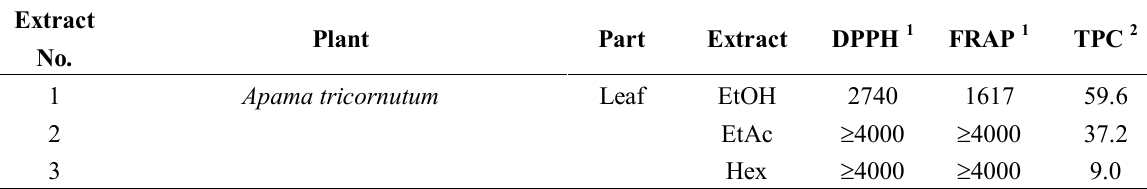
Table 1. Plant extracts used in this study and their antioxidant activity as determined by results of the 2,2-diphenyl-1-picrylhydrazyl (DPPH), ferric reduction activity potential (FRAP) and total phenolics content (TPC)